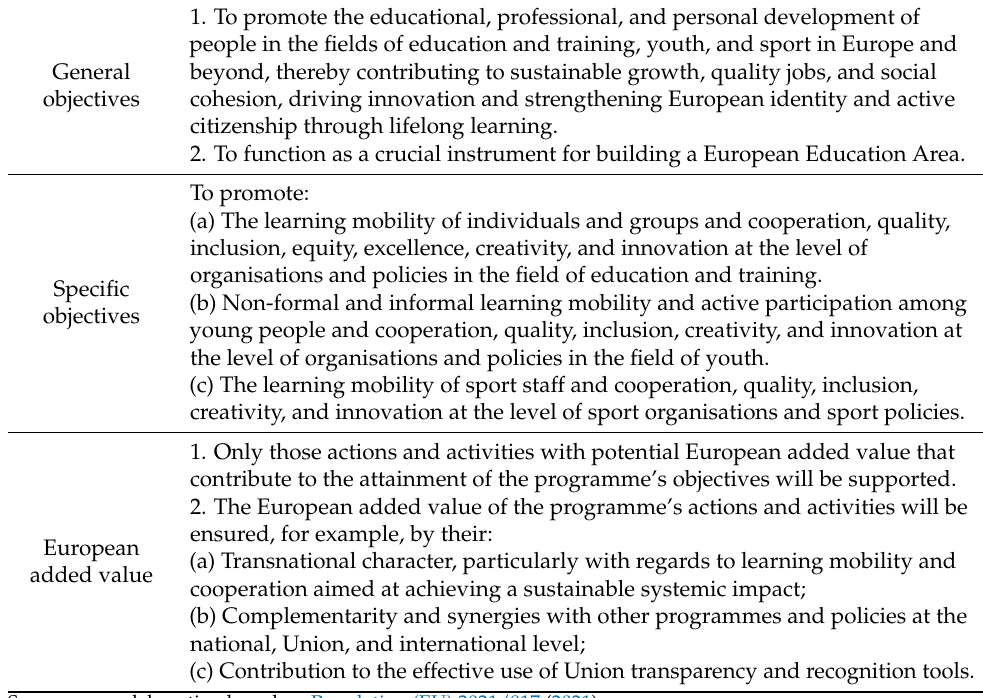
Table 2. Objectives and European added value of